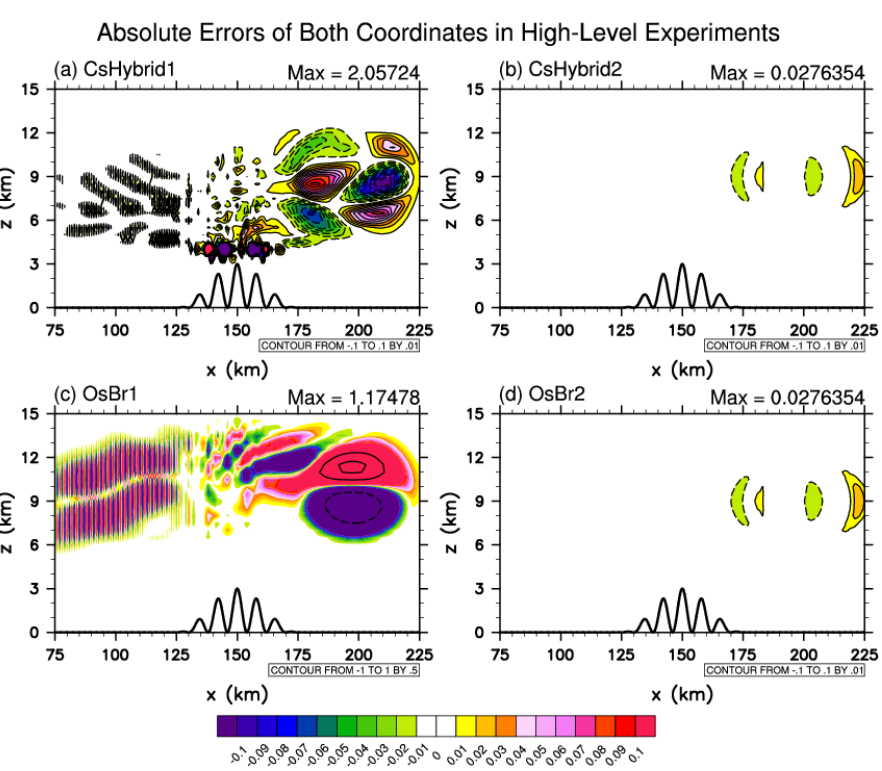
Figure 9. Absolute errors of the hybrid σ coordinate and the OS coordinate compared with the analytical solution in the Schär-type (high- level) experiments at the end of the integration. Shading represents the AE. The solid black contours are for positive values, and the dashed contours are for negative values. The contour interval is 0.01 in (a) , (b) , and (d) ; and that in (c) is 0.5. The solid black curve in the bottom of each figure represents the mountain.